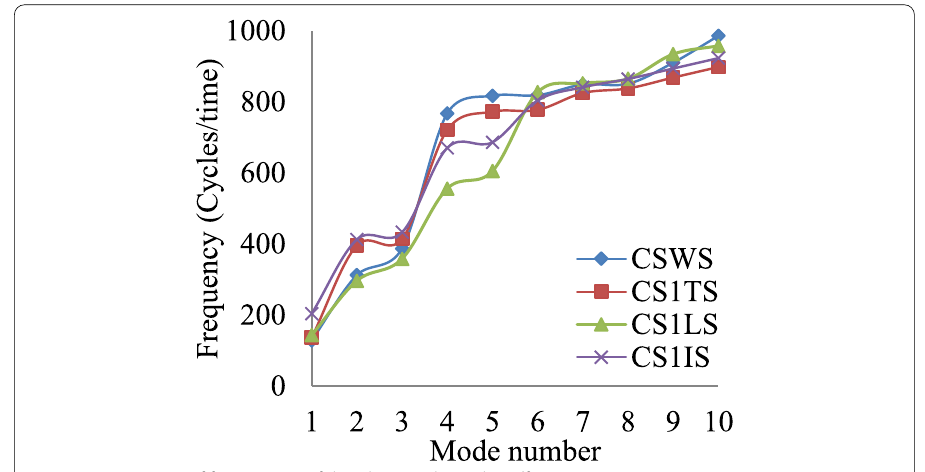
Fig. 7 Comparison of frequencies of the plates with single stiffener